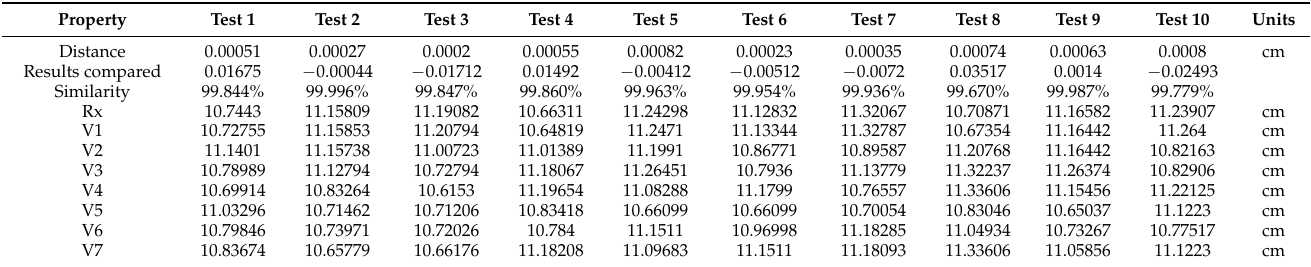
Table 1. Comparison of interpolation